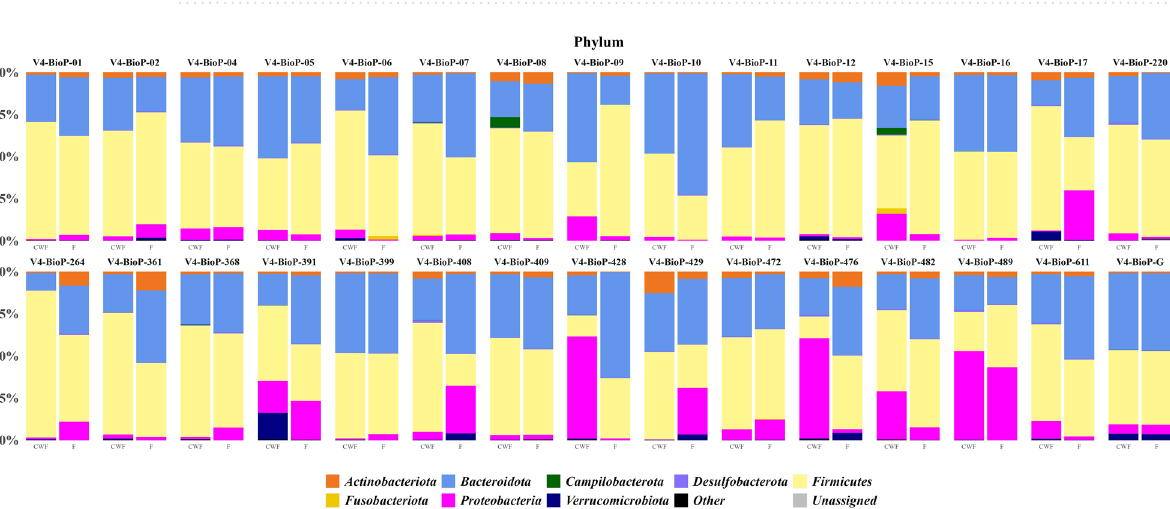
Figure 5. Bacteria relative abundances at the phylum level. Only taxa with a relative abundance equal or higher to 1% were shown. Rare taxa were collapsed as